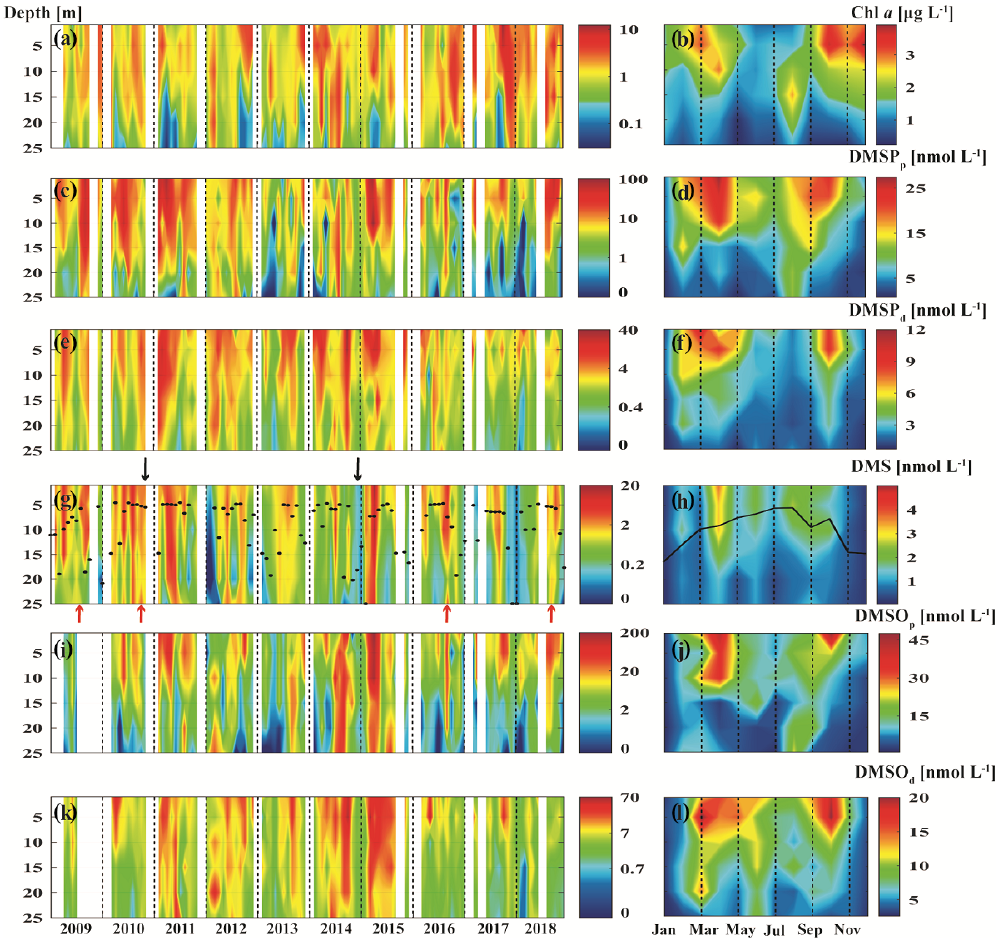
Figure 3. Monthly and mean seasonal distributions of chlorophyll a (a, b) , DMSP p (c, d) , DMSP d (e, f) , DMS (g, h) , DMSO p (i, j) and DMSO d (k, l) at BE during 2009–2018. Black dots (g) and the black line (h) indicate monthly and mean seasonal distributions of the MLD, respectively. The black arrows (g) indicate the major Baltic inflow (MBI) events in November 2010 and December 2014. The red arrows indicate elevated concentrations of DMS under hypoxia/anoxia in 2009, 2010, 2016 and 2018. In 2009, DMSO data were only available from April to July. Time–depth Hovmöller diagrams were generated with MATLAB, and concentrations shown in the left panels are given on a natural logarithmic